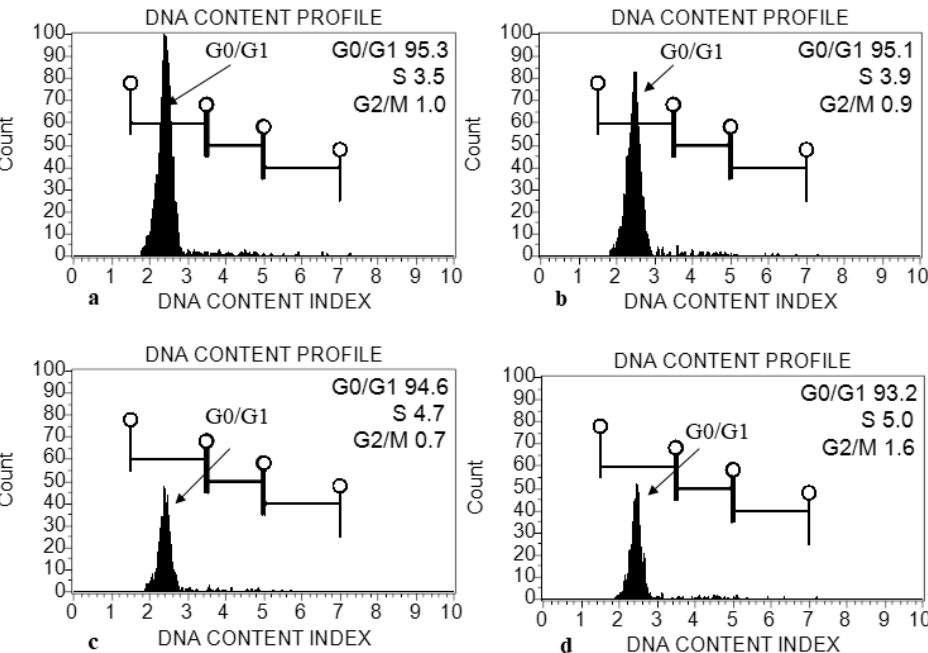
Figure 10. Histogram generated from propidium-iodide-stained nuclei isolated from young leaf of E. macrochaetus : ( a ) control (0 mg/L ZnO-NPs); ( b ) treatment T1 (10 mg/L, ZnO-NPs); ( c ) T2 (20 mg/L, ZnO-NPs); ( d ) T3 (40 mg/L, ZnO-NPs). Bars represented by different letters indicate significant val- ues according to Duncan’s test ( p < 0.05). Table 1. Genome size (2C and 4C DNA content) and mitotic index calculated from generated histo- gram using flowcytometry.